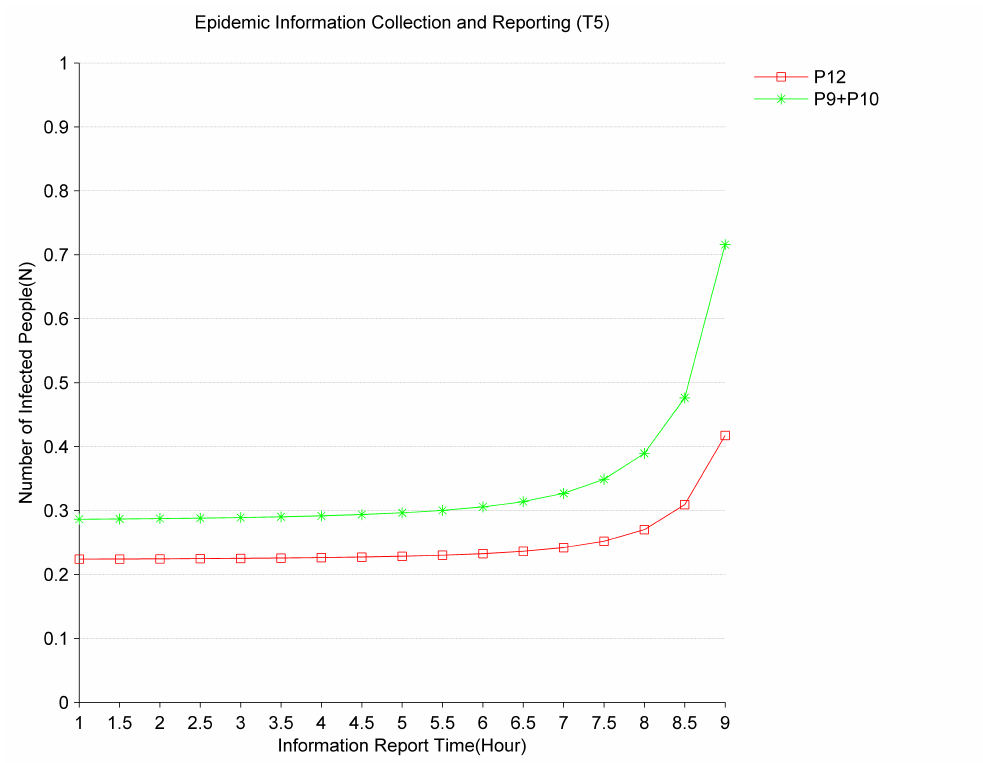
Figure 4. Impact of epidemic information reporting time (T5) on the evolution of the